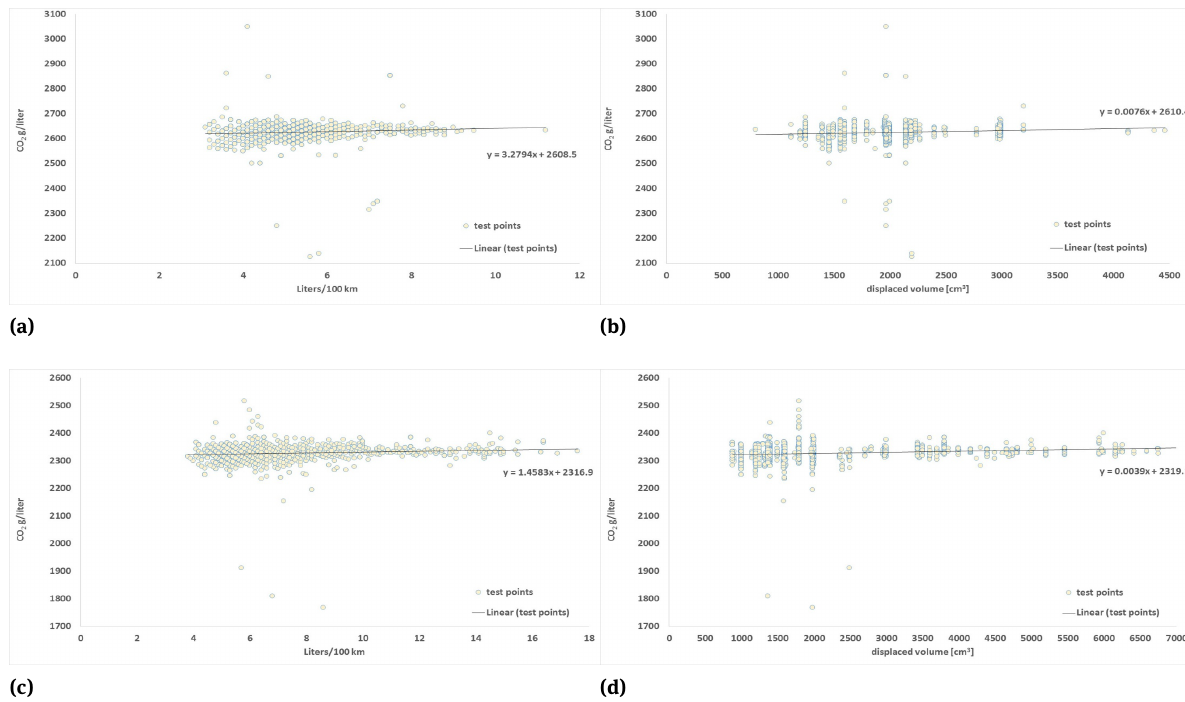
Fig. 2: Specific carbon dioxide emission during the tests of diesel (a, b) and petrol (c, d) passenger cars. The specific carbon dioxide emis- sion for comparison purposes should be one single value for diesel and one single value for petrol. Similarly the fuel energy content per liter is presently